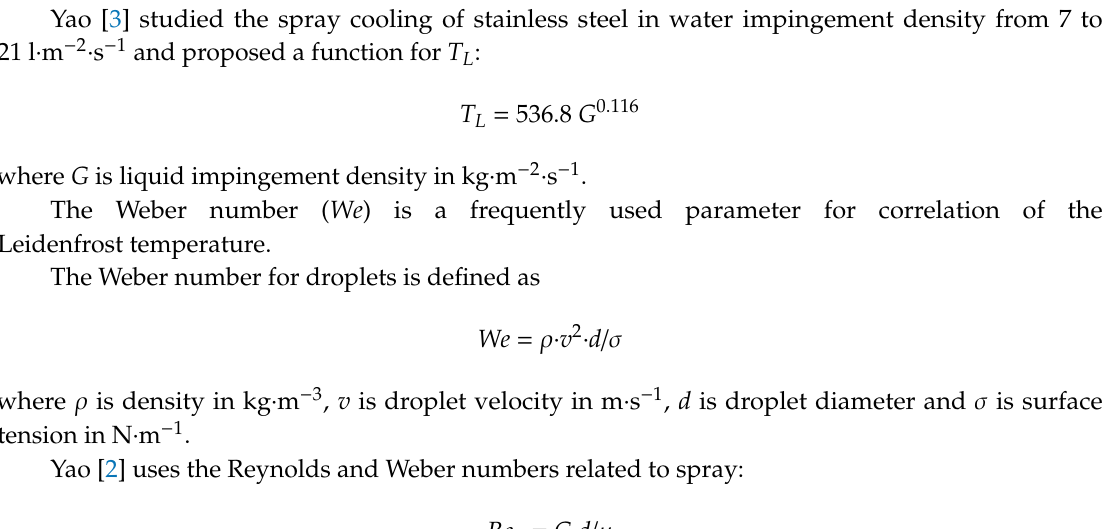
Figure 2. Example of HTC for one mist nozzle with di ff erent flowrate settings, Leidenfrost temperature in a range from 500 ◦ C to over 1200 ◦